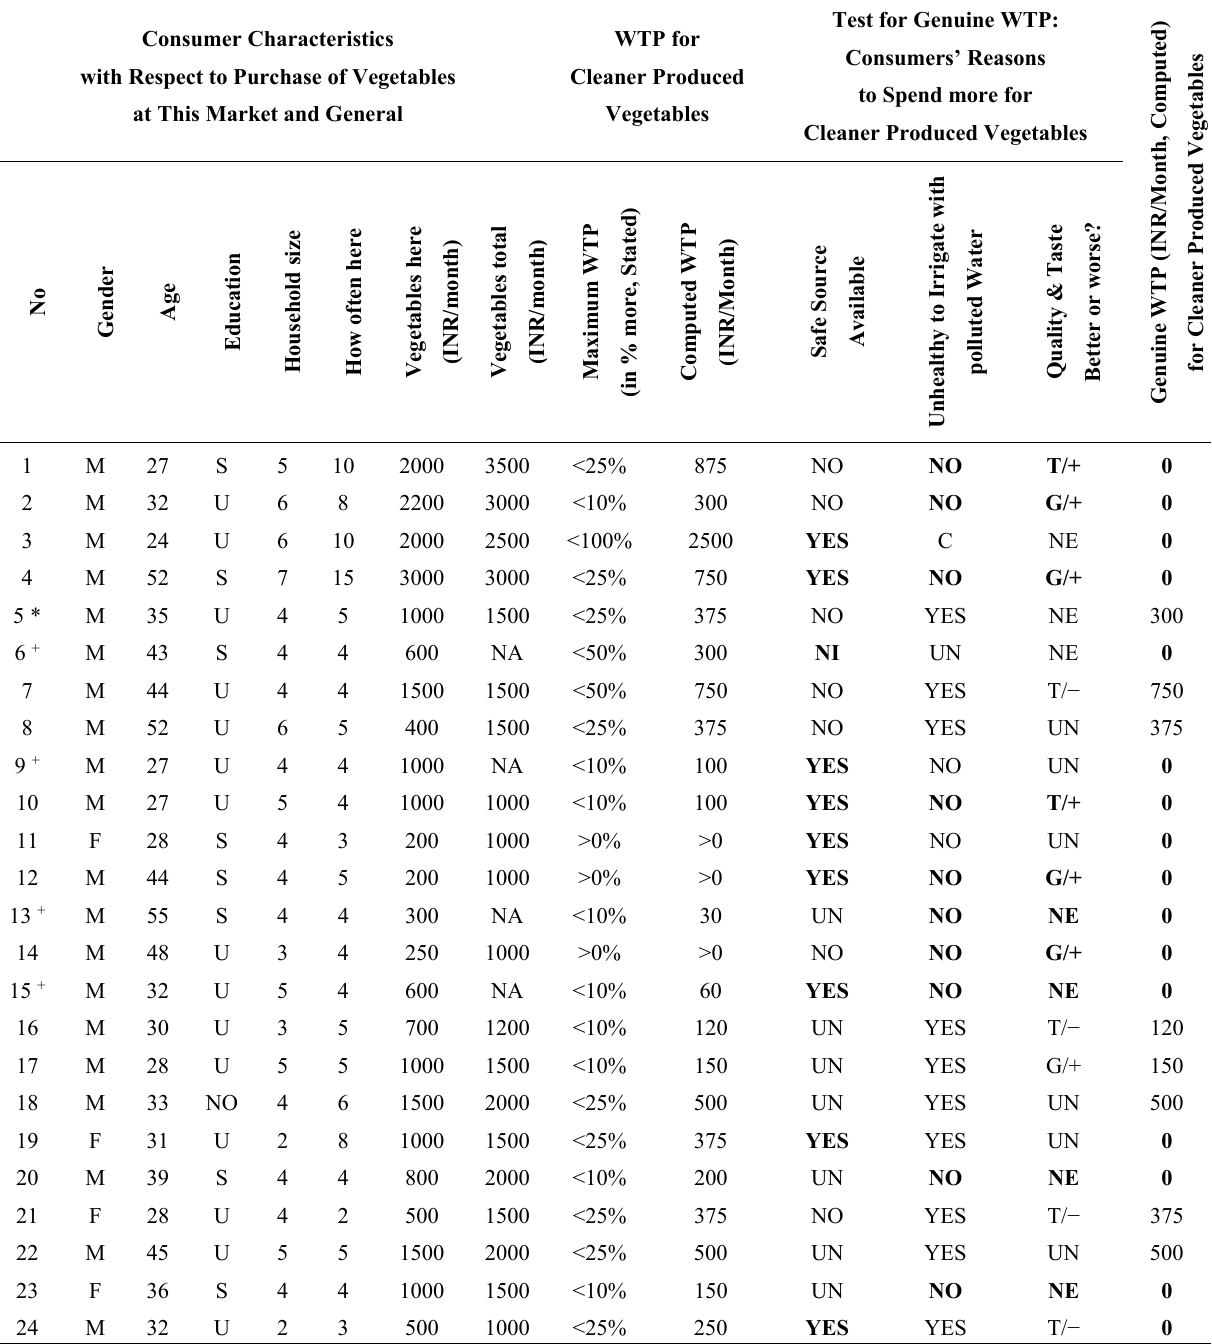
Table 5. Elaborating on consumers’ genuine willingness to pay for using cleaner irrigation water. Consumer